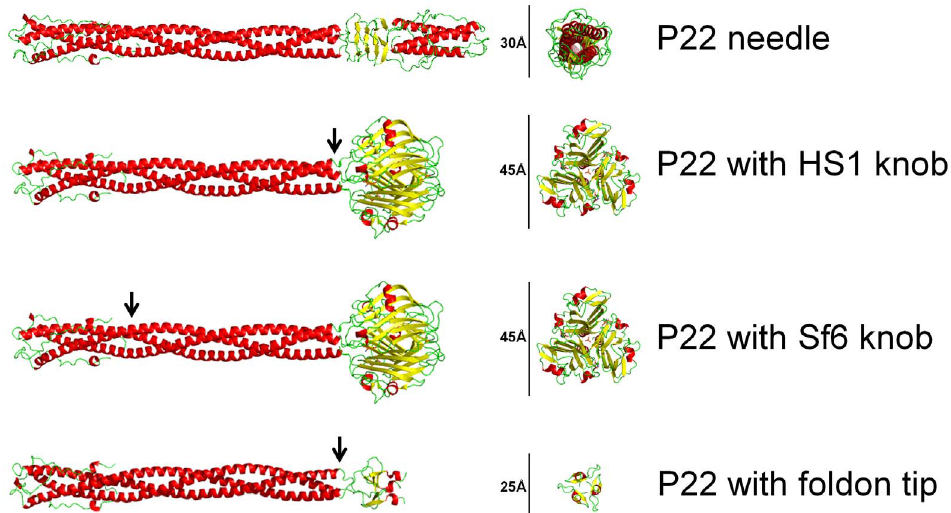
Figure 3. Structural models of the P22 gp26 tail needle and chimeric tail needles. A . Crystal structure of P22 tail needle gp26 (pdb 3C9I). B–D . Homology structural models of chimeric P22 needles with Sf6 knob (in phage UC-0911), HS1 knob (in phage UC-0926) and foldon tip (in phage UC-0927). Chimeric models were generated for illustration with align function of PyMol (Version 1.3, Schrodinger, LLC, San Carlos, CA), where C- terminal knob domains of Sf6 and HS1 tail needle (pdb 3RWN, 4K6B), C-terminal foldon domain from fibritin fiber of the bacteriophage T4 (pdb 1AA0) were fused downstream of P22 gp26 tail needle helical core residues 1–140 (pdb 3C9I), respectively. In all three models, arrow indicates point of fusion.